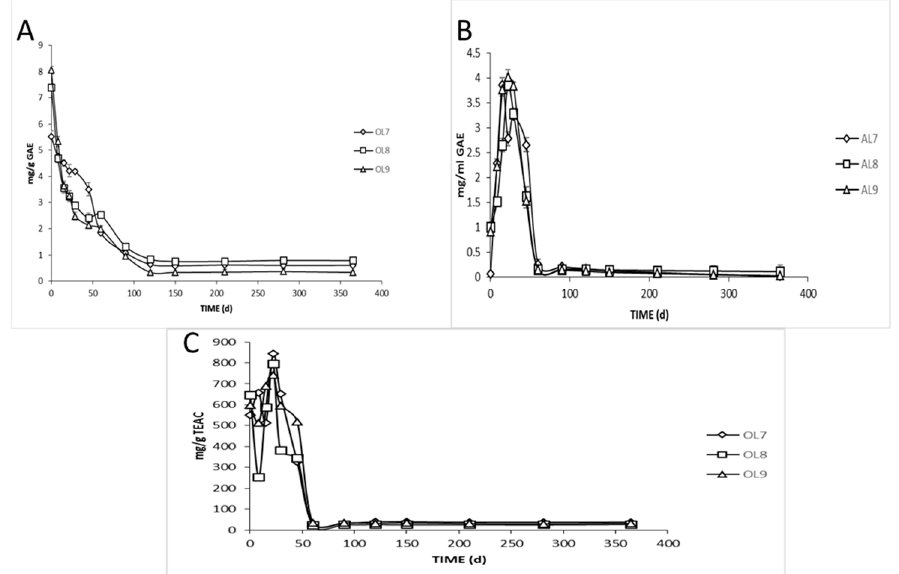
Figure 3. Total phenolic content of olive pulps ( A ) and brines ( B ) and antioxidant capacity of olives ( C ) during spontaneous ( ◊ ), inoculated (10% NaCl) ( □ ), and inoculated (7% NaCl) ( ∆ ) fermentation of Cypriot green cracked table olives. Results are expressed as means and standard deviations of three replicates, equivalent of mg/g or mL.